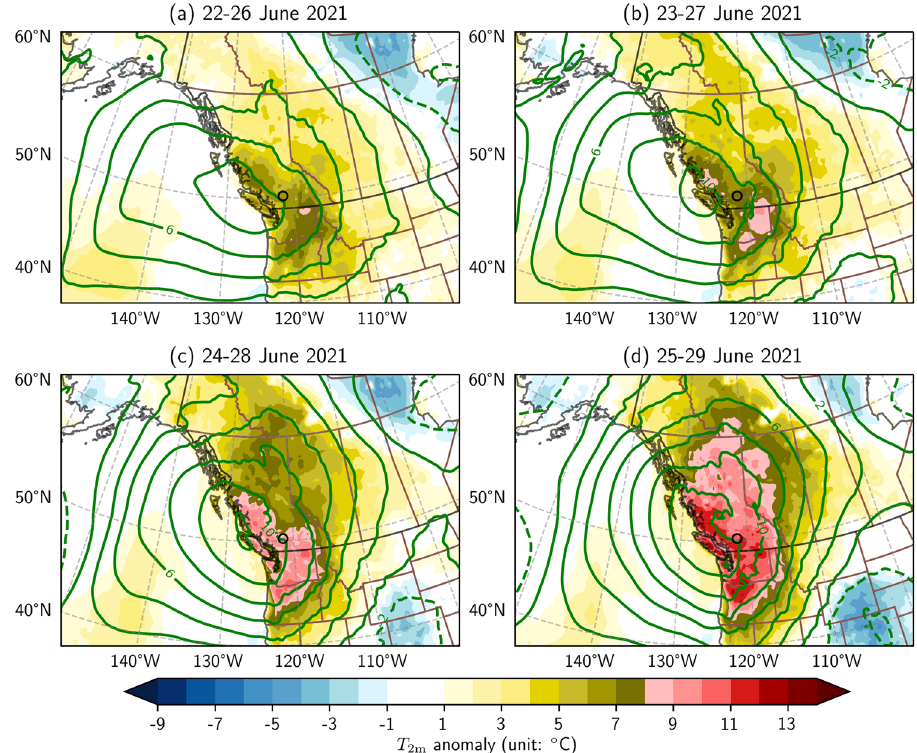
-- T de fi ned in “ Methods ” , line contours with intervals of 2 °C) and the 2 m Fig. 5 The 5-day mean anomalies of the low-level averaged temperature ( temperature ( T 2m , colour- fi lled). The four overlapped 5-day periods are a 22 – 26, b 23 – 27, c 24 – 28, and d 25 – 29 June 2021. Data are from the ERA5 reanalysis. The anomalies are calculated based on the 30-year (1991 – 2020) climatology. The small circle indicates the location of Lytton, BC, where the highest temperature ever measured in Canada was recorded at 49.6 °C on 29 June